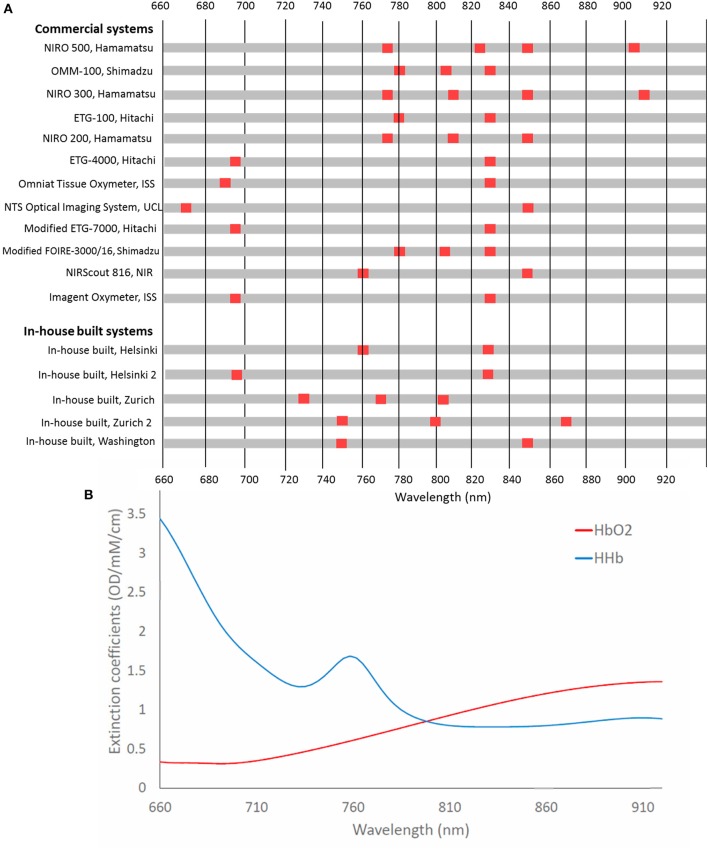
(A) Chart showing wavelengths used in NIRS systems used in functional studies of newborns <1 month of age. Systems are listed in chronological order from their first publication as used for this application. (B) Extinction spectra for HbO2 and HHb for the corresponding wavelengths.